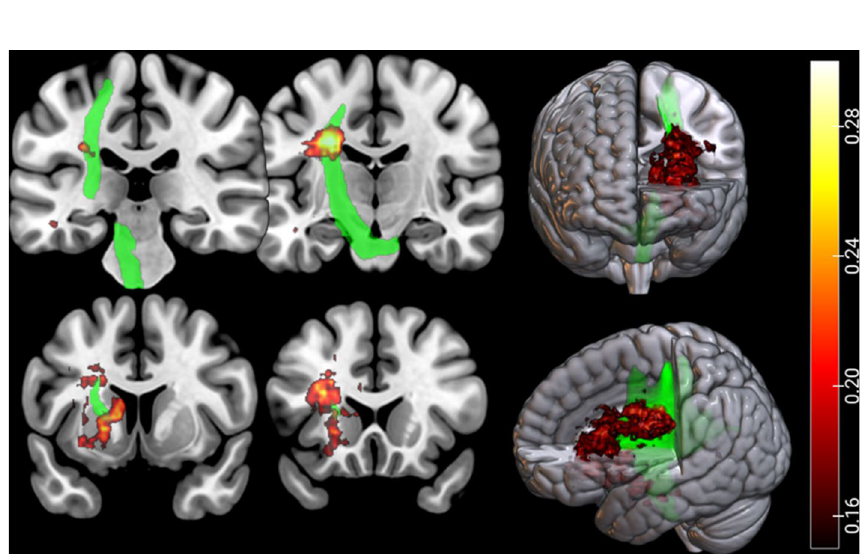
Figure 4. Spatial relationship between the lesion and corticospinal tract. The subtracted percentage map (the difference map of percentage of overlapped lesions) was overlaid on the corticospinal tract (green). The colour bar represents the subtracted percentage of overlapped lesions from the patients in the CRPS and control groups. MR images are displayed according to neurological convention. The lesion site from our experimental results substantially overlapped with the descending pathway of the corticospinal